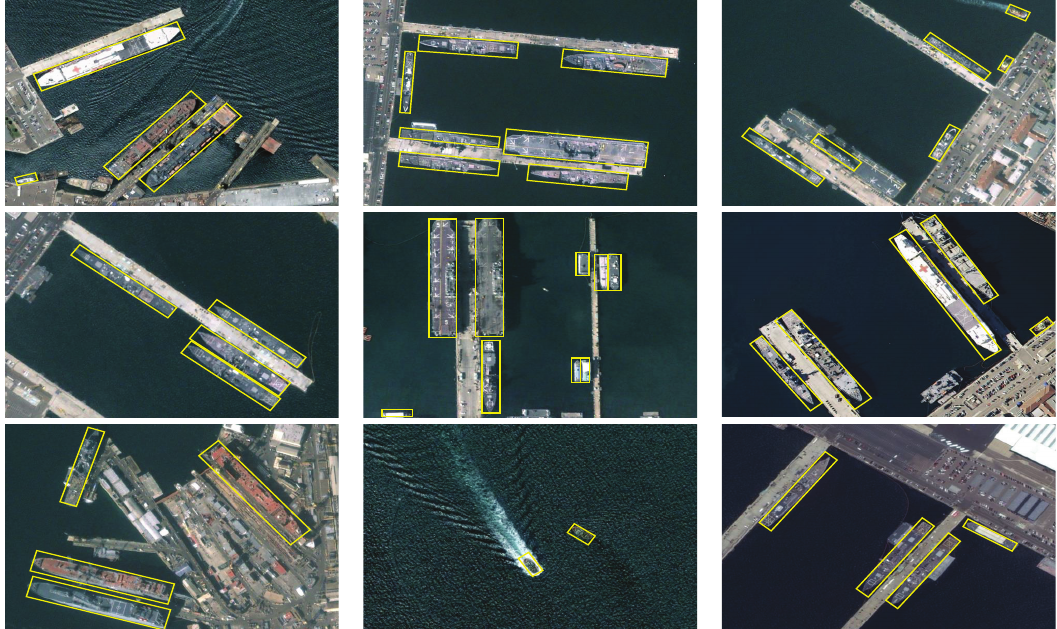
Figure 8. Visualization of the detection results of our method on the HRSC2016 dataset.